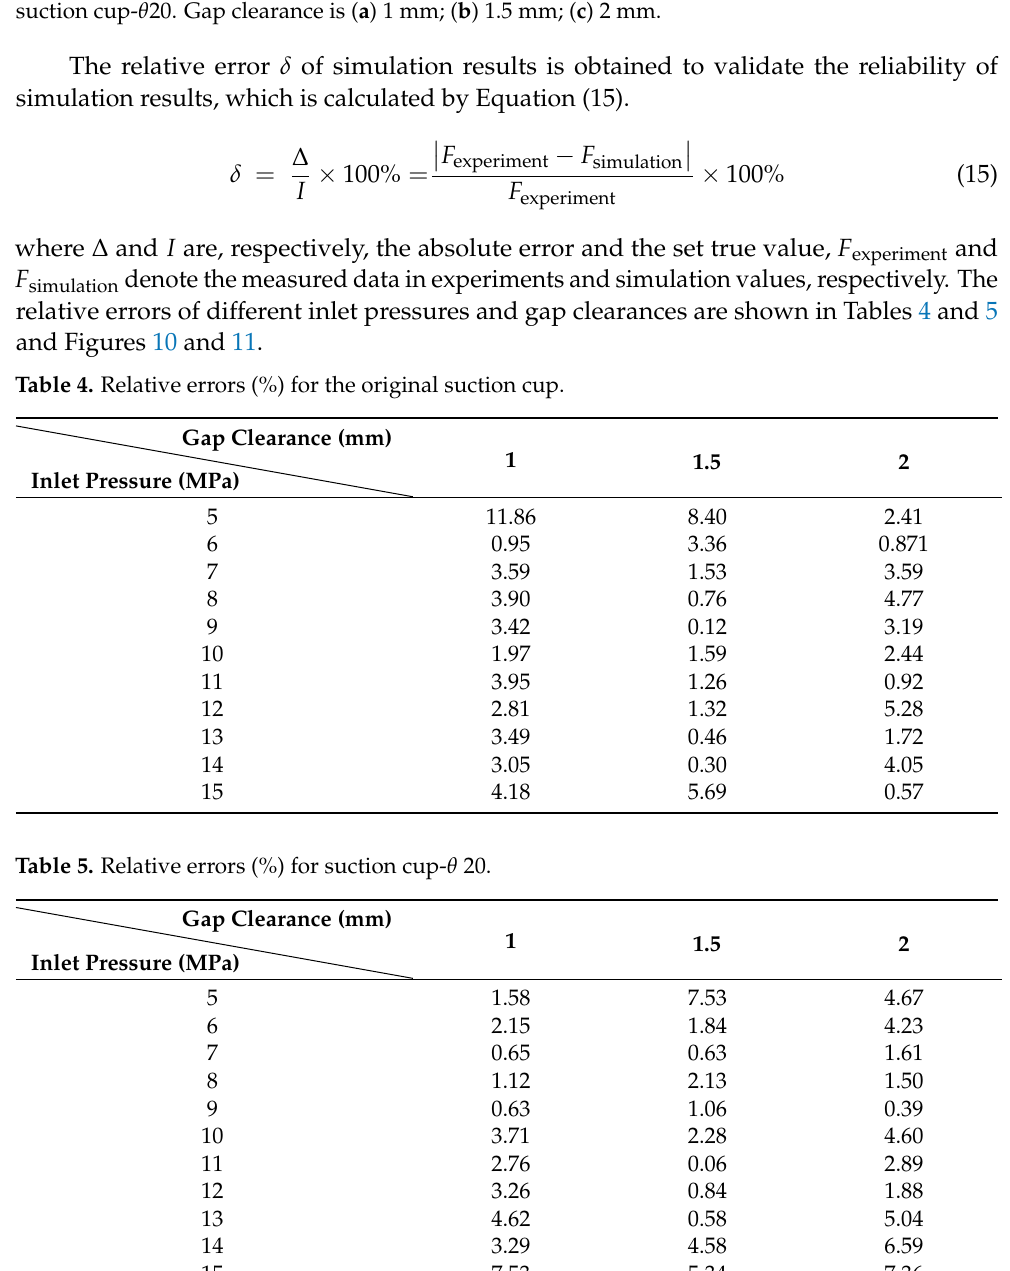
Table 5. Relative errors (%) for suction cup-